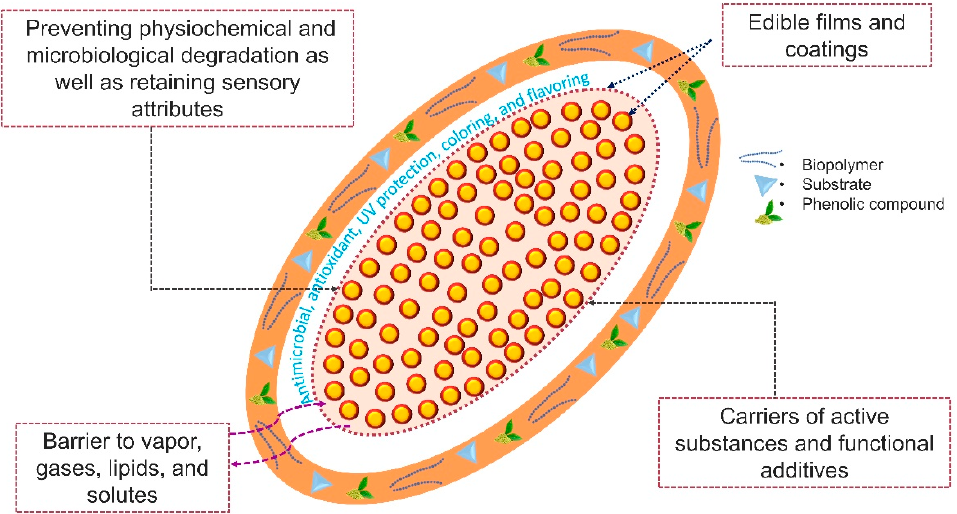
Figure 3. Enhancements in the characteristics of edible films/coatings containing phenolic com-